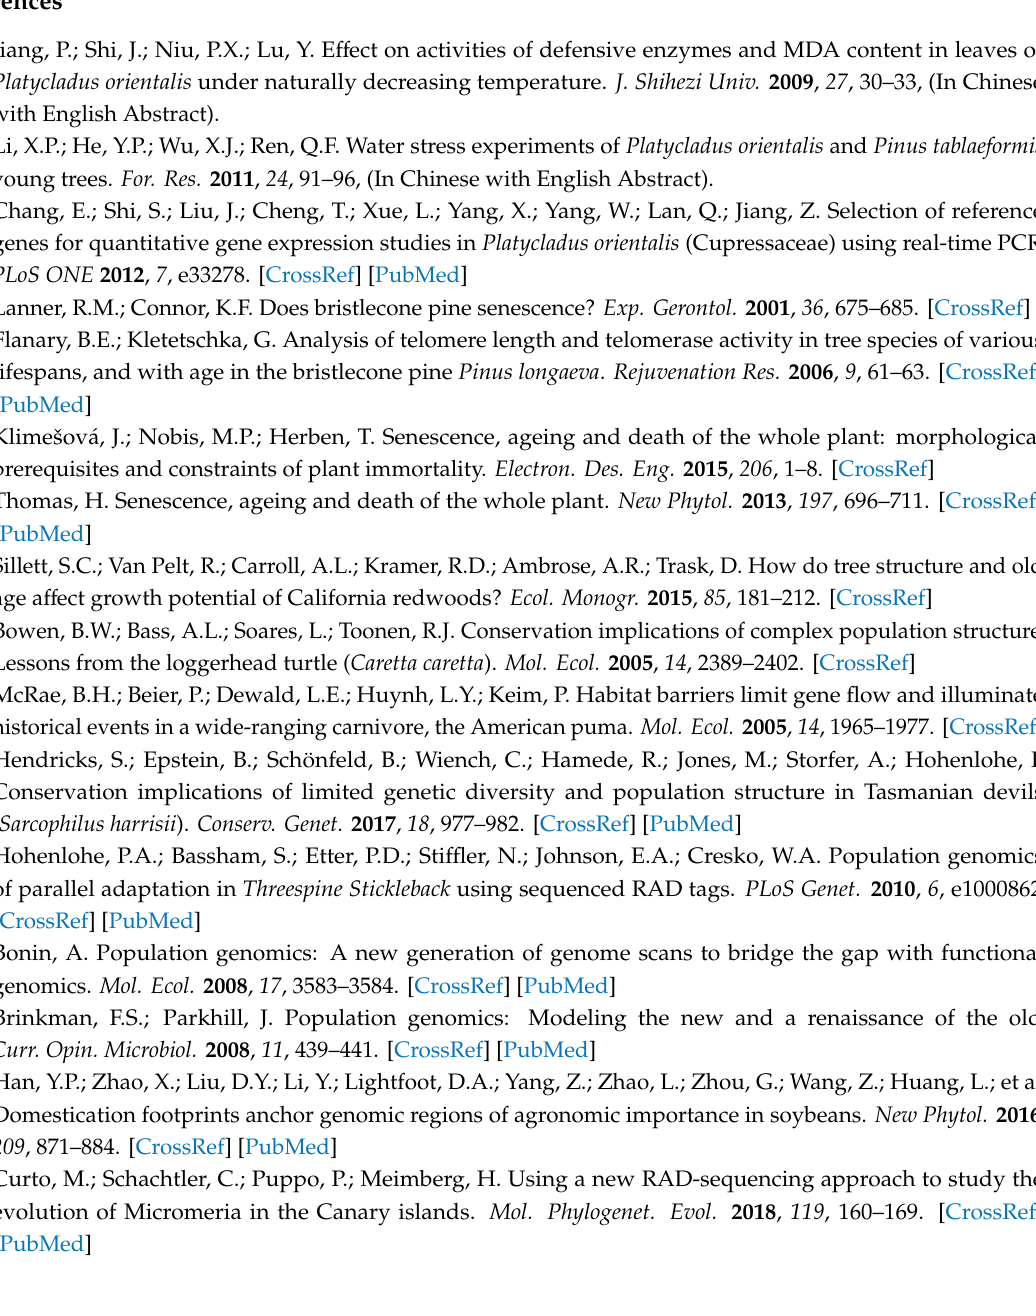
Supplementary File S3: Tajima’s D value of all populations. Supplementary File S4: Selected regions for the GS-W and BJ-Z